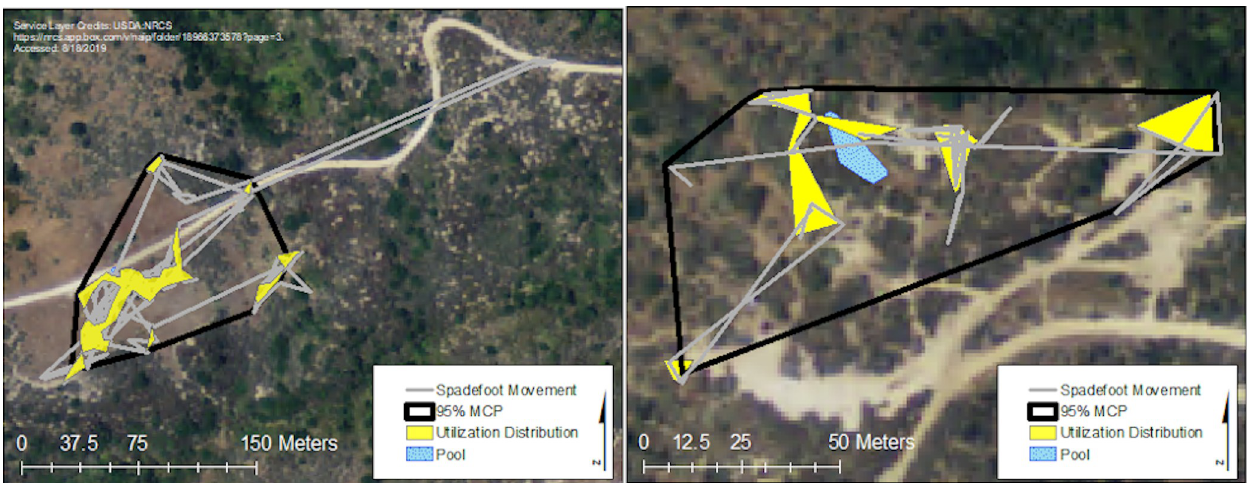
Fig 1. Home range and utilization distribution of spadefoots. Home ranges (black outline) represented as 95% minimum convex polygons, and utilization distribution (yellow polygons) of adult western spadefoots in Orange County, California, USA, in 2012 for Laguna Coast Wilderness (left) and Crystal Cove State Park (right). Blue solid polygons show the breeding pool at each site.